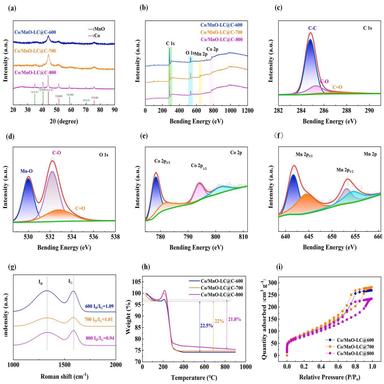
(a) XRD spectra for Co/MnO-LC@C-600, Co/MnO-LC@C-700 and Co/MnO-LC@C-800. (b) Survey XPS spectra for Co/MnO-LC@C composites; the highresolution XPS spectra of (c) C 1s, (d) O 1s, (e) Co 2p, and (f) Mn 2p for Co/MnO-LC@C-700. (g) Raman spectra for Co/MnO-LC@C composites. (h) TGA curve of Co/MnO-LC@C composites in the O2 atmosphere. (i) N2 absorption-desorption isotherms for Co/MnO-LC@C composites.